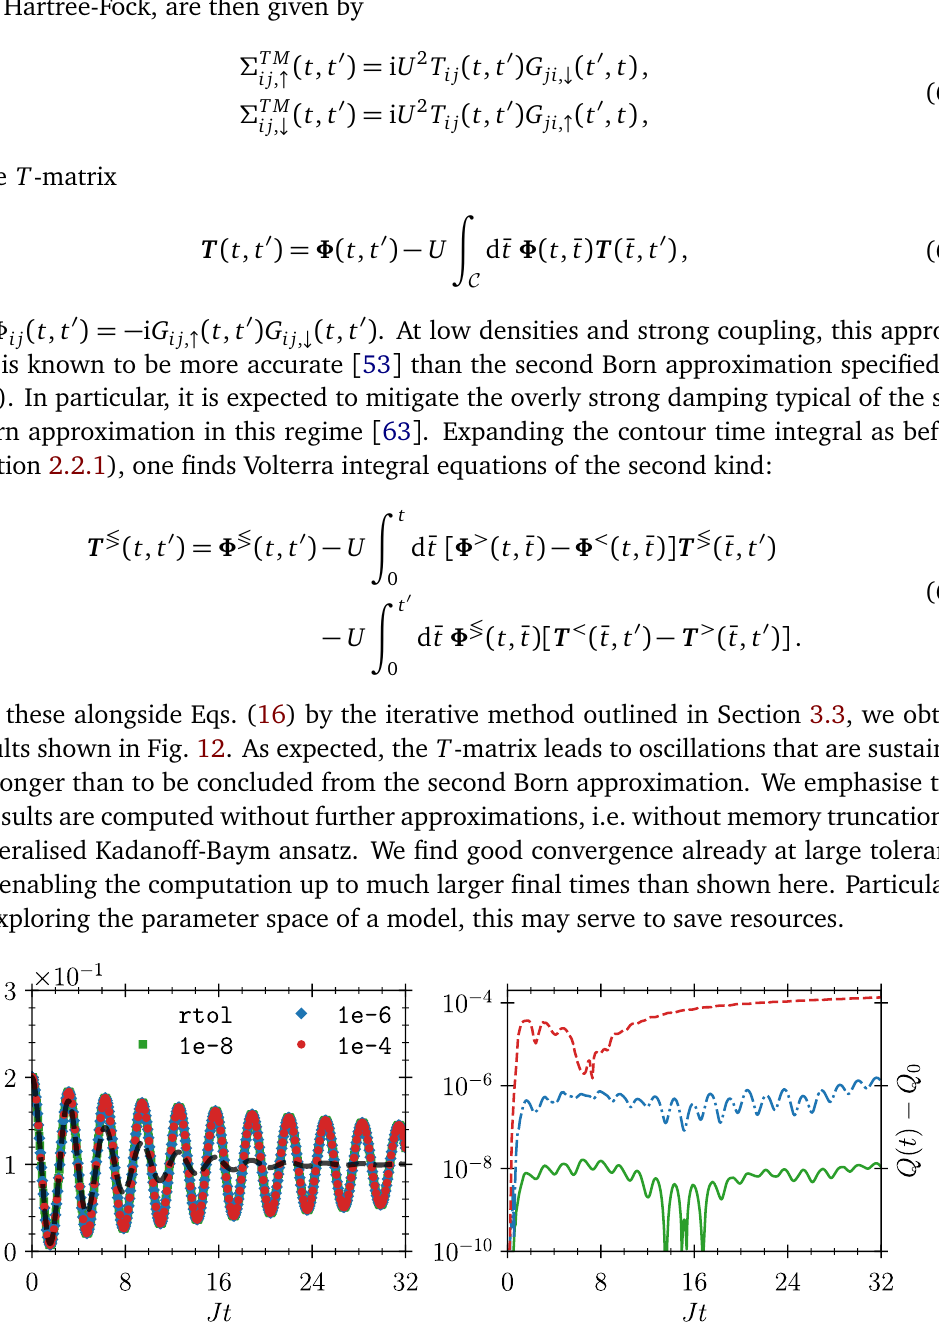
Figure 12: Long-time evolution of the eight-site Fermi-Hubbard lattice (Fig. 8) in the T -matrix approximation, with interaction U / J = 2 and initial conditions ( 0,0 ) = G < ( 0,0 ) = idiag ( 0.1,0.1,0.1,0.1,0.0,0.0,0.0,0.0 ) . The initial total G < ↑ ↓ = 0.8, while for spin we have S = 0.0. Different values of charge is hence Q 0 0 rtol are presented, with atol/rtol=1e-2 in all cases. The (black) dashed line in the left panel shows the second Born approximation. Note that while the results are converged for any of the tolerances chosen here, the conservation laws are adhered to more strictly with more conservative